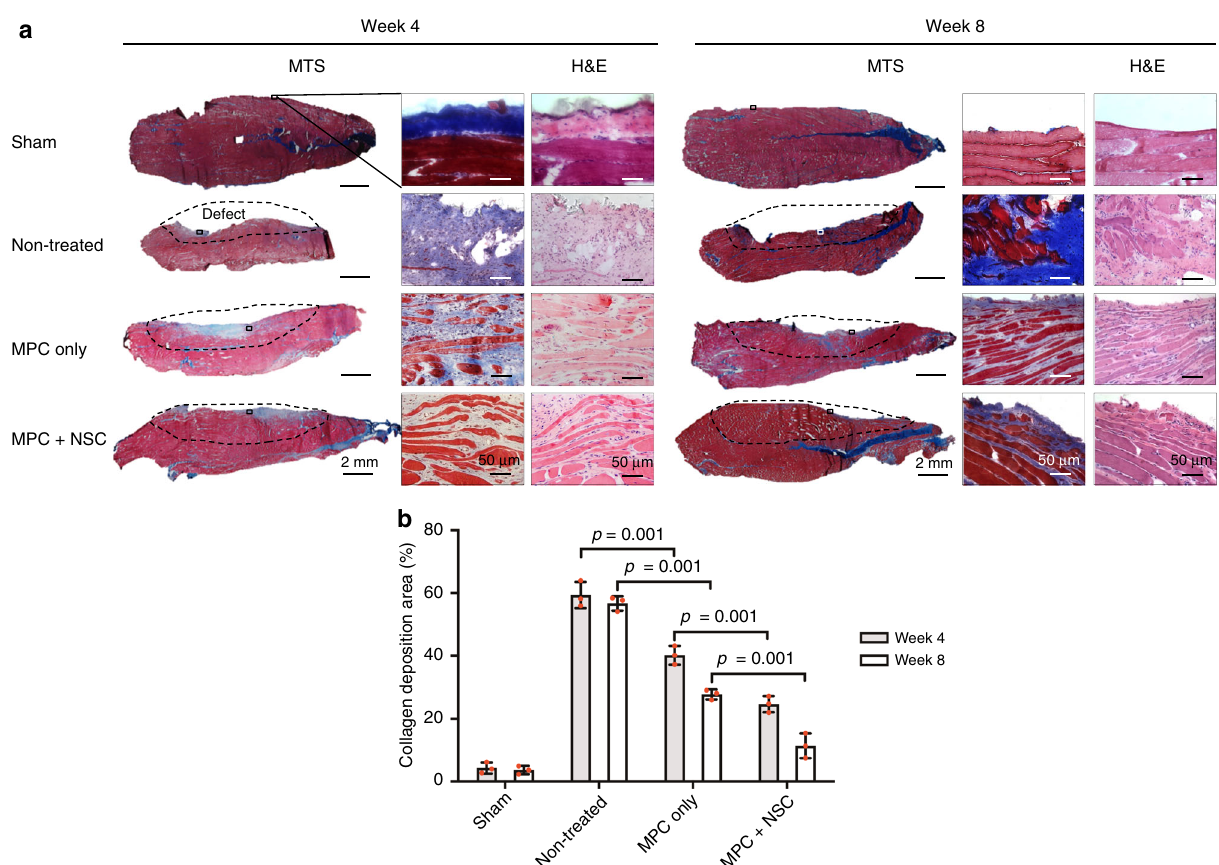
Fig. 5 Histological examination. a Skeletal muscle regeneration by 3D bioprinted constructs at 4 and 8 weeks after implantation. The MPC + NSC group showed aligned, newly formed muscle fi bers with reduced fi brosis and maintenance of muscle volume. Dashed lines; defected area. MTS: Masson ’ s trichome staining. H&E: hematoxylin and eosin. b Quanti fi cation of the area of collagen deposition (%) using MTS staining results ( n = 3 per group and time point, four random fi elds per sample). All data are represented as mean ± SD. The p -values by two-way ANOVA followed by Tukey ’ s test are